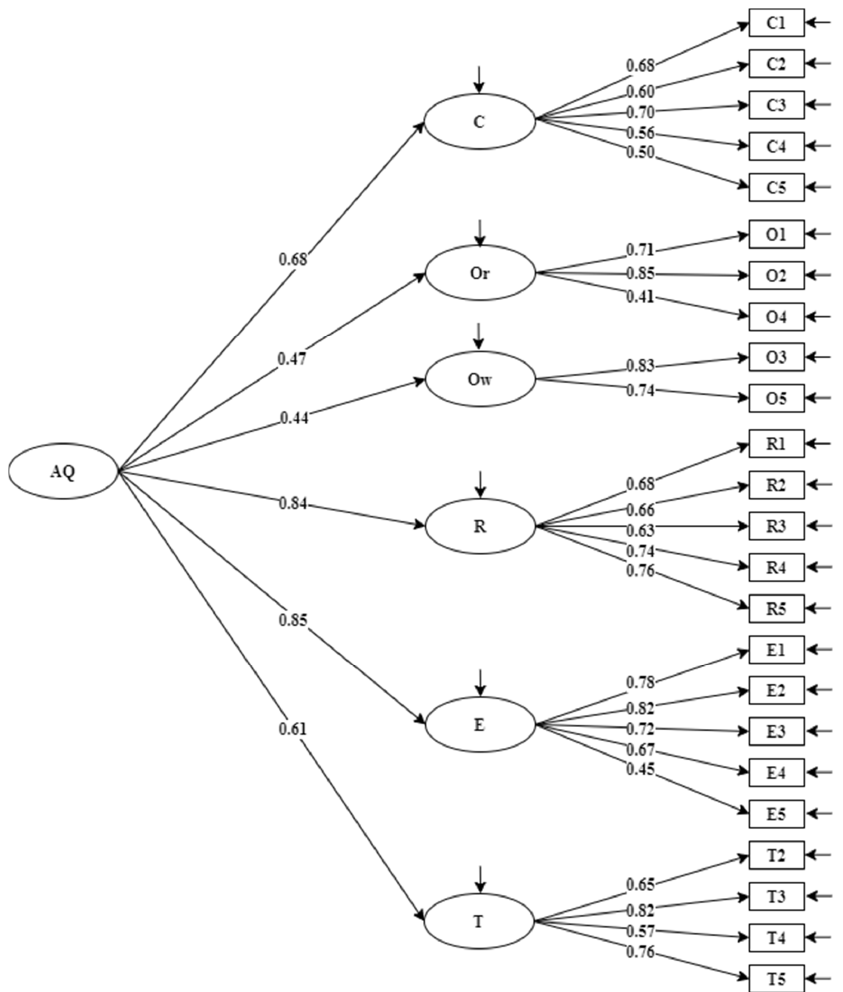
Figure 1. Model 1 with standardized factor loadings on control (C), ownership (Ow), origin (Or), reach (R), endurance (E), transcendence (T), and adversity quotient (AQ) ( n =